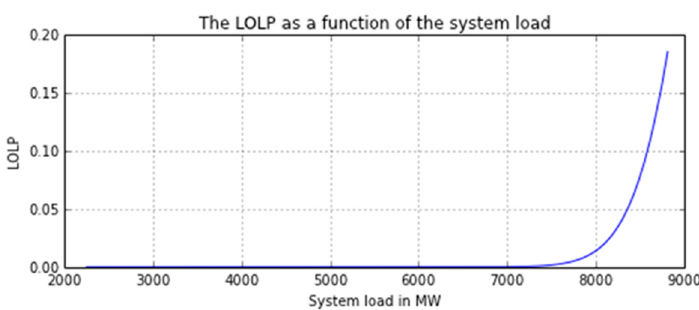
Figure A3. Density plot for wind power capacity factor for Greece.